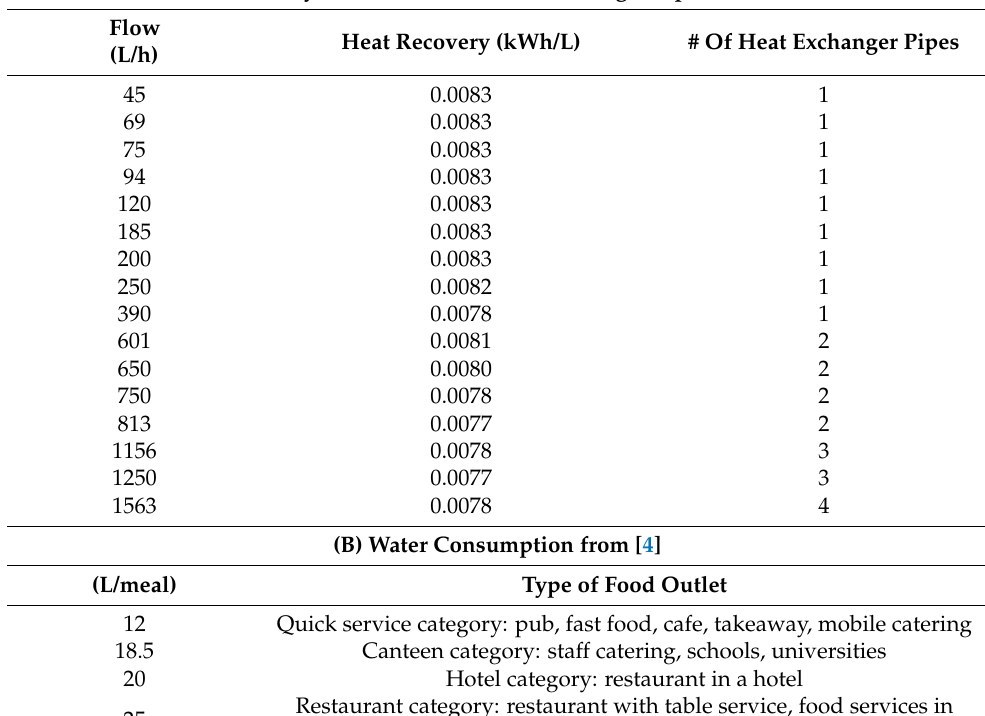
Table 1. Background data on (A) flow-specific heat recovery potential and (B) water consumption per meal.